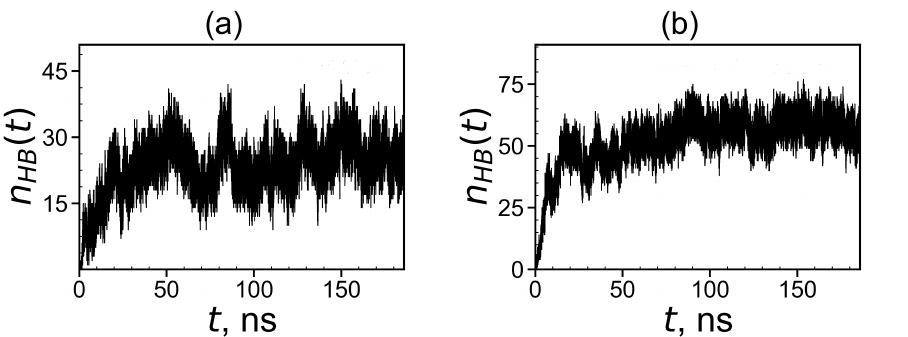
Figure 15. Time dependences of the number of hydrogen bonds n hb ( t ) between the Lys–2His or Lys–2Hisp dendrimers and 16 AEDG peptides during the complex formation: ( a ) Lys2His + 16AEDG and ( b ) Lys2Hisp +